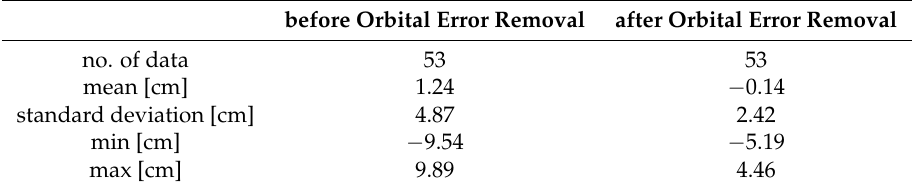
Table 1. InSAR Zenith Total Delay (ZTD) vs. GNSS ZTD–Silvi Marina test